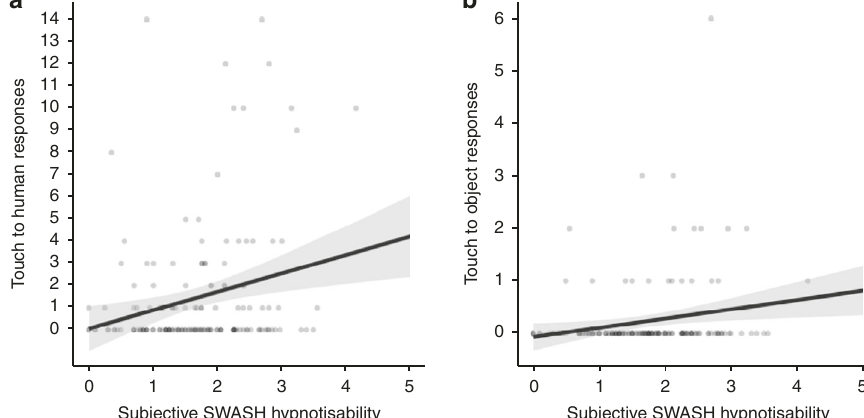
Fig. 2 Scatter plots showing linear regression of mirror touch measures on hypnotisability ( n = 154 participants). a Touch to human responses, Spearman ’ s r s = 0.19, 95% CI [0.04, 0.34]. b Touch to object responses, Spearman ’ s r s = 0.21, 95% CI [0.06, 0.36]. Error bars show 95% CI. The centre of credibility intervals is the predicted score. Note: SWASH is an abbreviation of Sussex-Waterloo Scale of